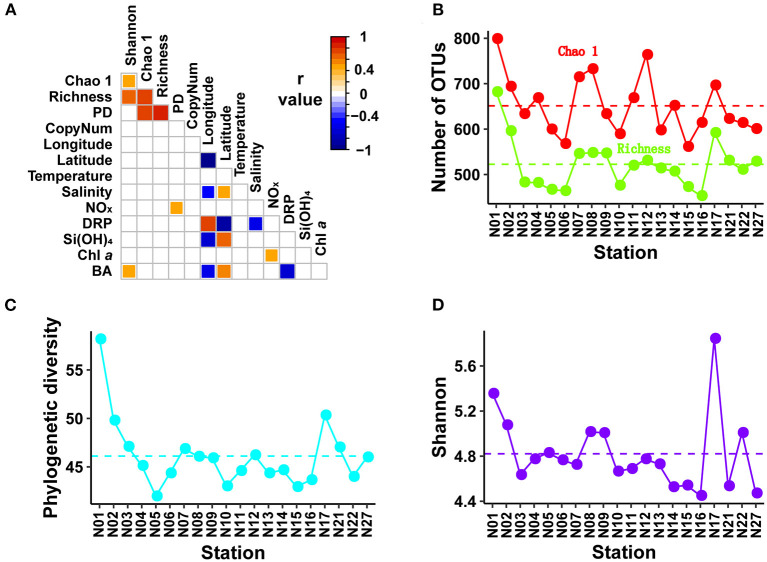
Spearman correlation matrix and distribution patterns of bacterial α-diversity indices. The Spearman correlation matrix (A) showing the results of Spearman rank correlation tests among α-diversity indices, environmental variables, geographic factors, and copy number of 16S rRNA gene. The p-values were corrected using package “psych.” Only adjusted p < 0.05 are shown in the Spearman correlation matrix with color indicating the r value. Distribution patterns of α-diversity indices including Chao1 and richness, PD, and Shannon are shown in (B–D), respectively. PD, phylogenetic diversity; CopyNum, copy number of 16S rRNA gene; NOx, nitrite + nitrate; DRP, dissolved reactive phosphorus; BA, bacterial abundance.